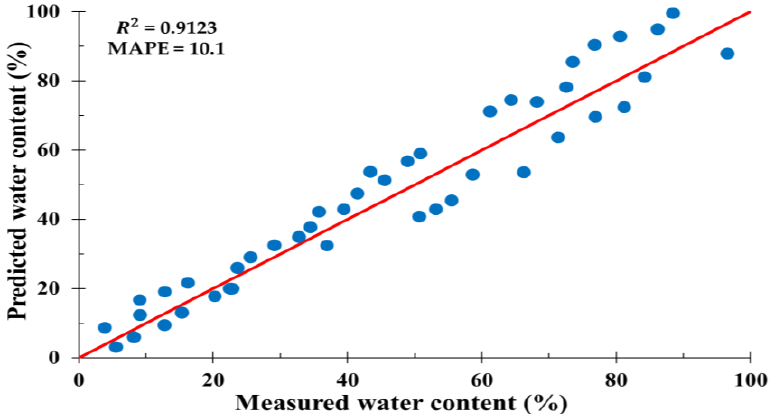
Figure 9. Comparison of measured water content versus water content predicted using the ANN model.